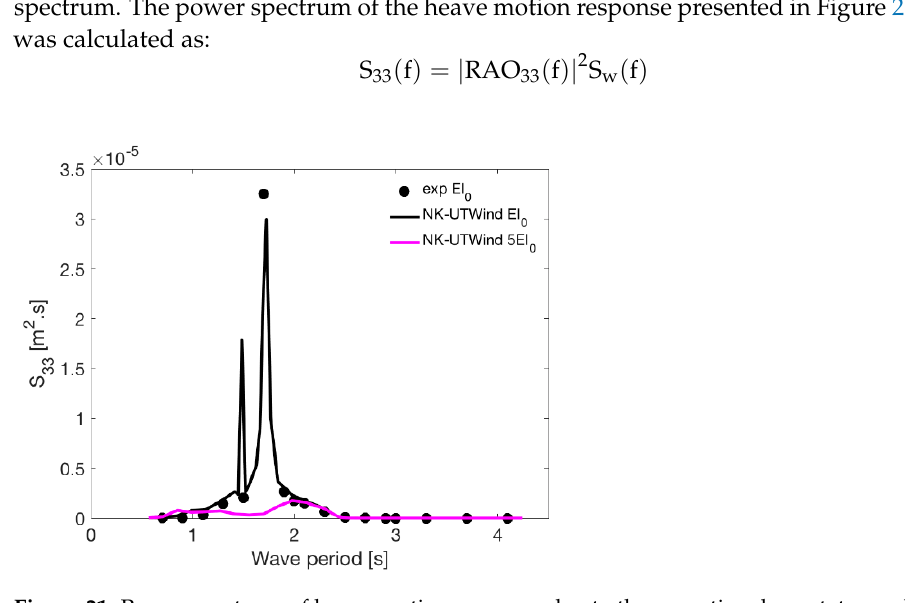
Figure 21. Power spectrum of heave motion response due to the operational sea state condition.